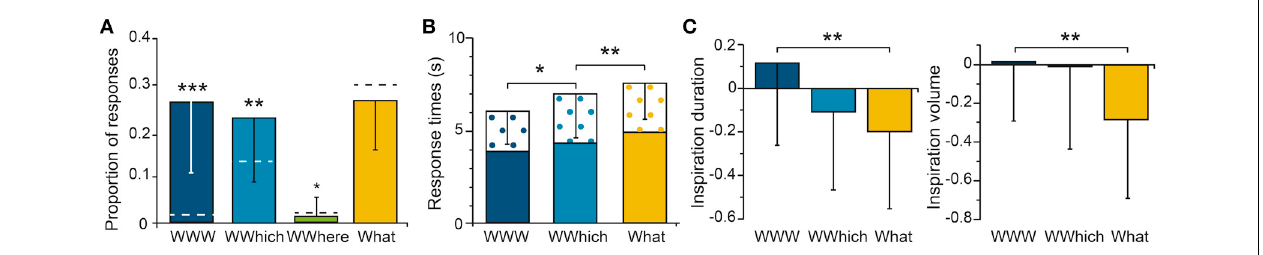
FIGURE 4 | Episodic retrieval. (A) Mean proportions of episodic combinations (WWW, WWhich, WWhere, What). (B) Mean response times for each episodic combination, with the delay between the odor recognition and episodic retrieval responses represented in black crosses. (C) Mean